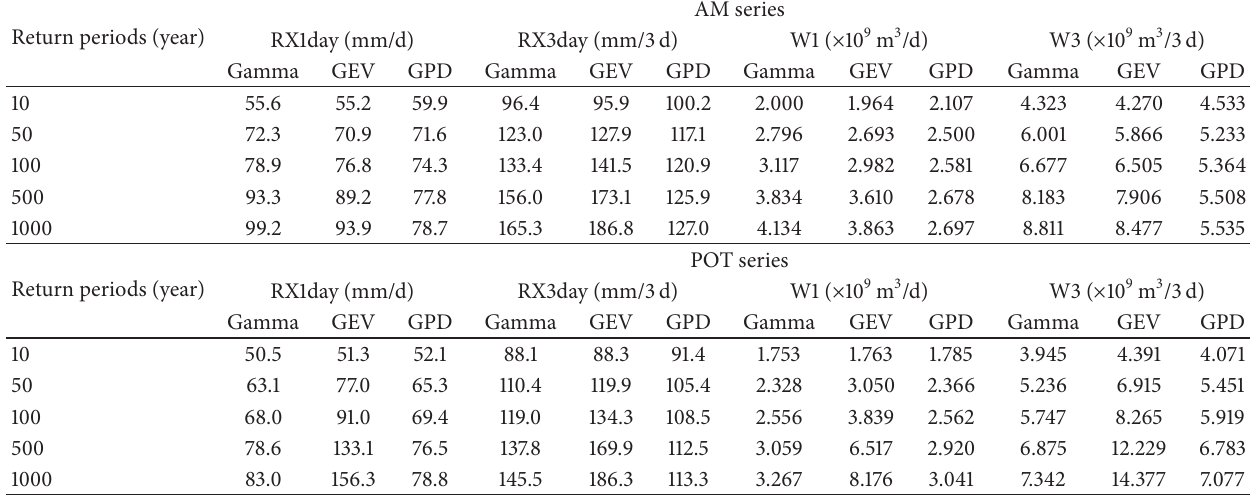
Table 3: Extreme precipitation and flood discharge estimated via marginal distribution models for a range of return periods.